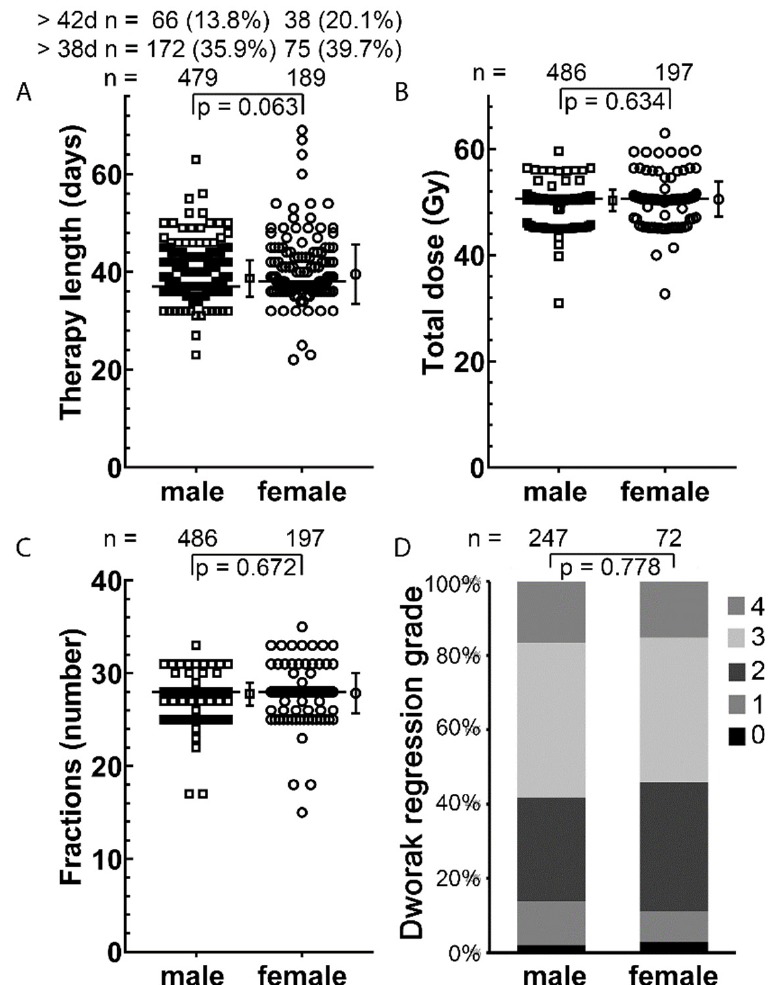
Figure 6. Therapy length, total dose and number of fractions of the entire cohort: ( A ) Length of therapy in days of 479 men and 189 women; ( B ) Total dose applied in Gy; ( C ) Number of fractions irradiated. The line indicates the median; ( D ) Regression of the cancer cells after RCT of the radiosensitivity cohort. Dworak regression grade means 0 is no regression and 4 is no remaining cancer cells. The mean and standard deviation are shown to the right of the dot plots; p -values were calculated by the Student’s t -test and the Fisher's exact test were used for regression.